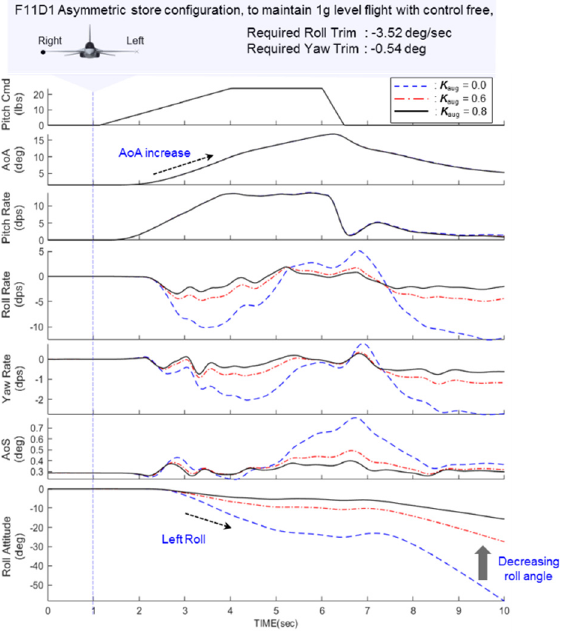
Figure 12. Simulation results of lateral-directional flying qualities to pull up maneuver in M0.8, 20 Kft altitude.